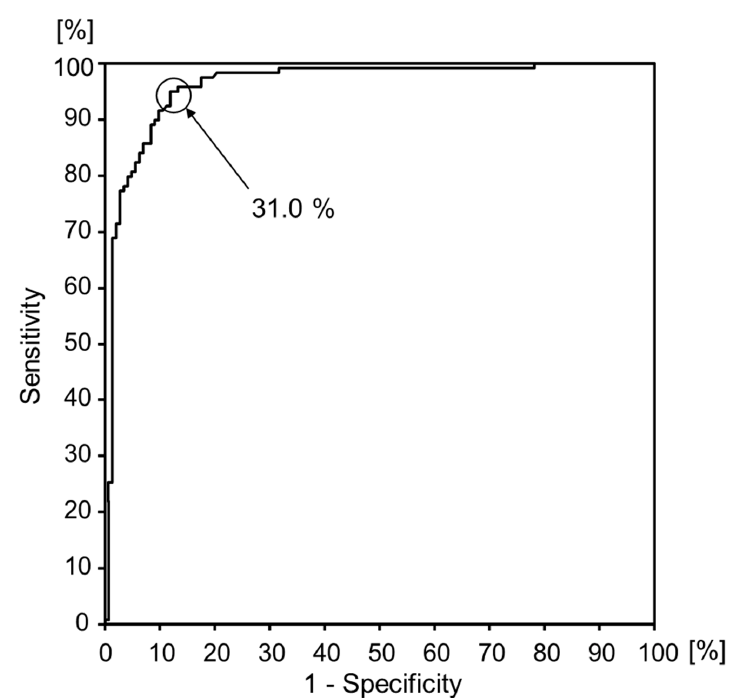
Figure 3. ROC analysis of walking speed in the ≥ 1.0 m/s group. The cutoff value for step length-to-height ratio identified by ROC analysis was determined to be 31.0%, with a sensitivity of 95.8%, 1-specificity of 85.9%, and area under the curve value of 0.96 (95% CI: 0.94–0.99, p < 0.01).